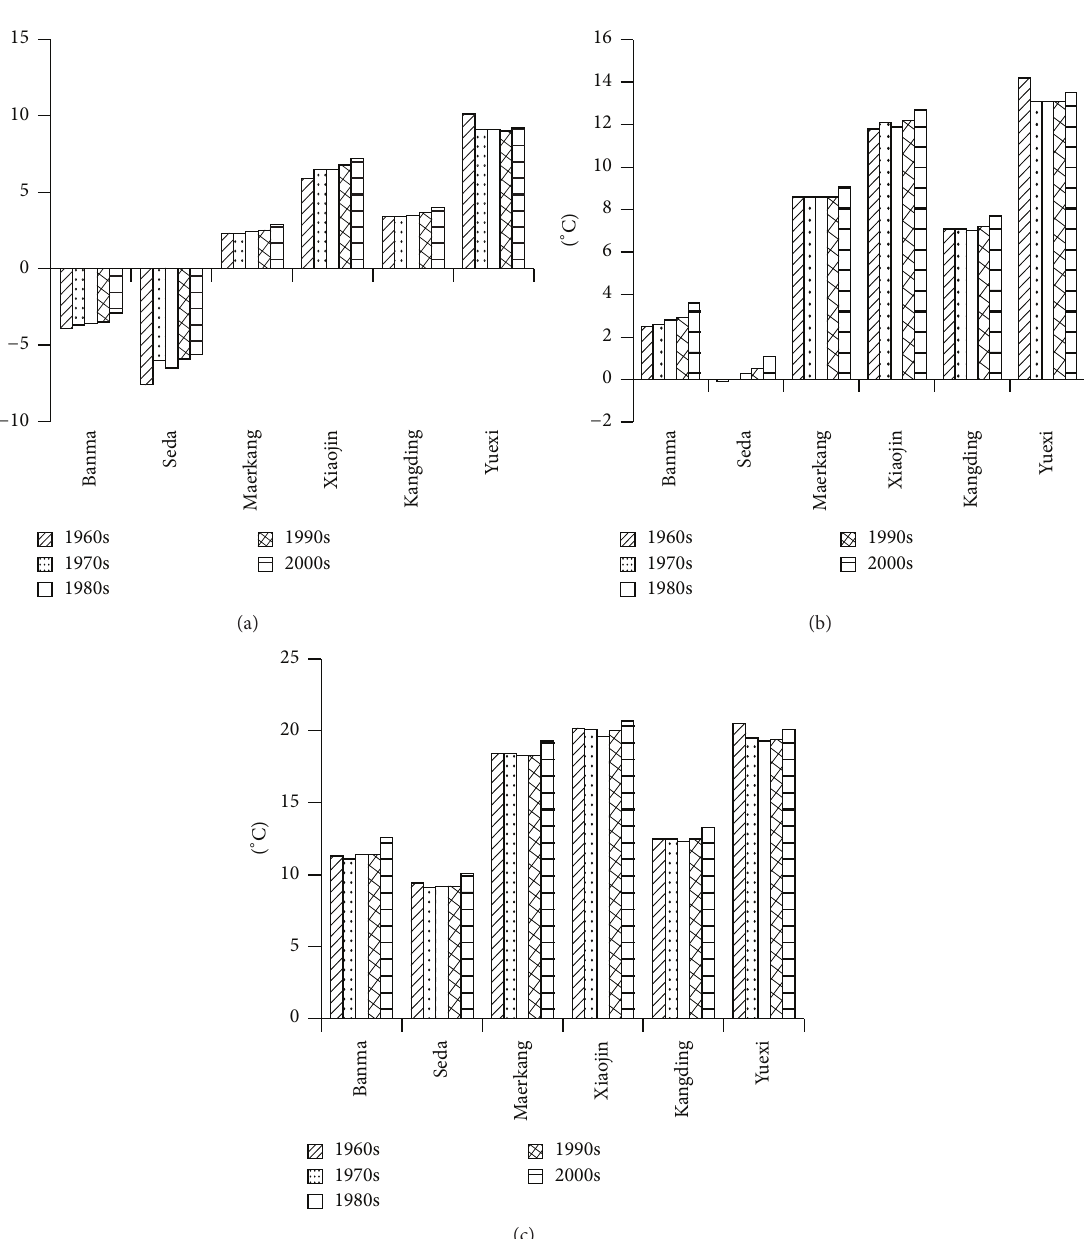
Figure 3: Variation of decade average temperature in the study area. (a) Minimum. (b) Mean. (c)